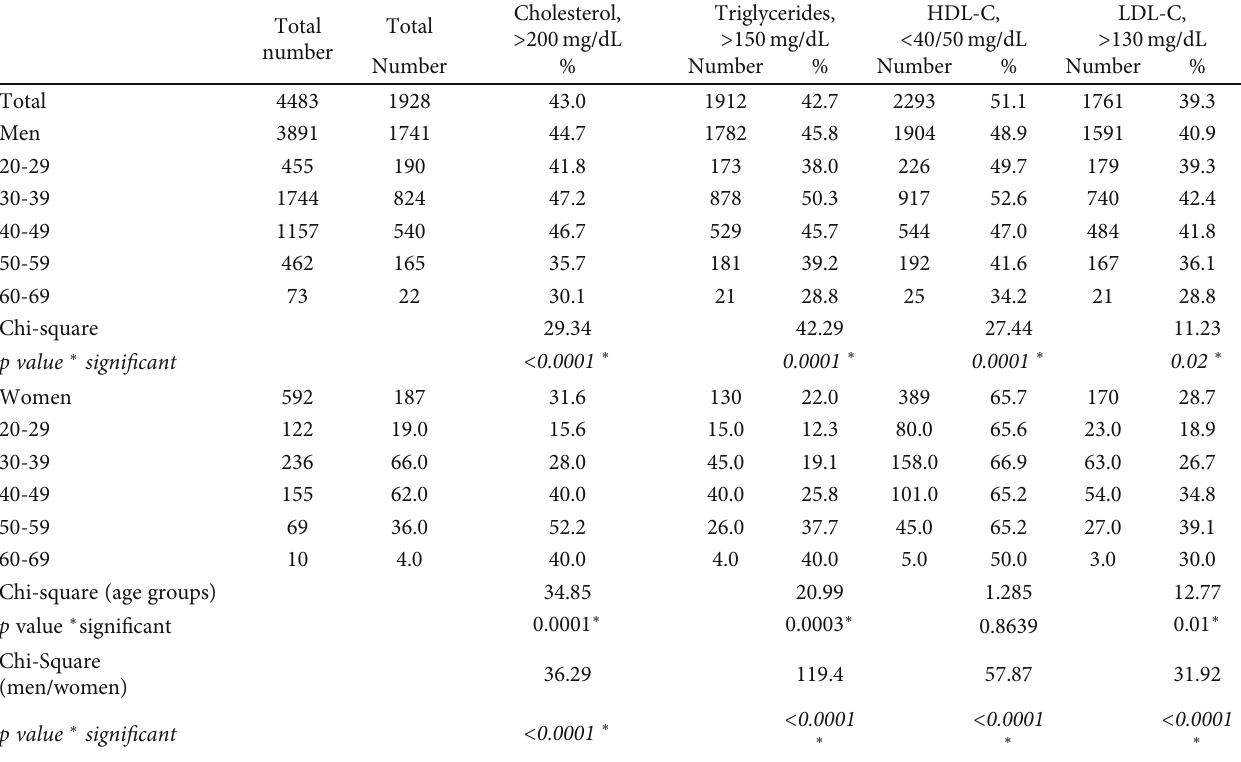
Table 2: Prevalence of Dyslipidemia among Indian Expatriates in Qatar, by gender and age.